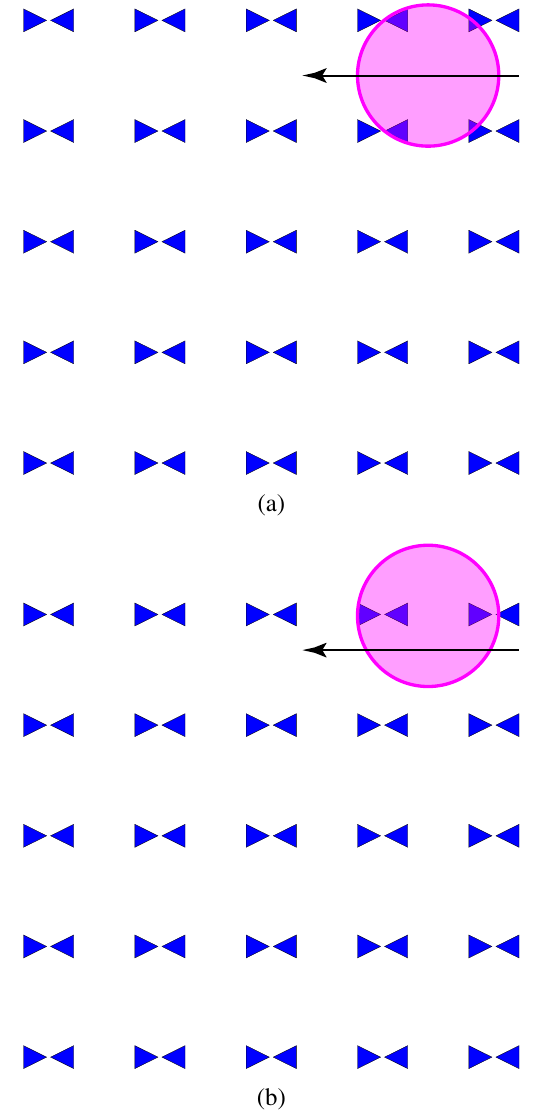
Figure 6: Movement of a spherical particle of diameter 600 nm above a 5 × 5 array of nanoantennas with 475 nm periodicity. (a) Moving on a path between two rows. (b) Moving on a path above the first row of